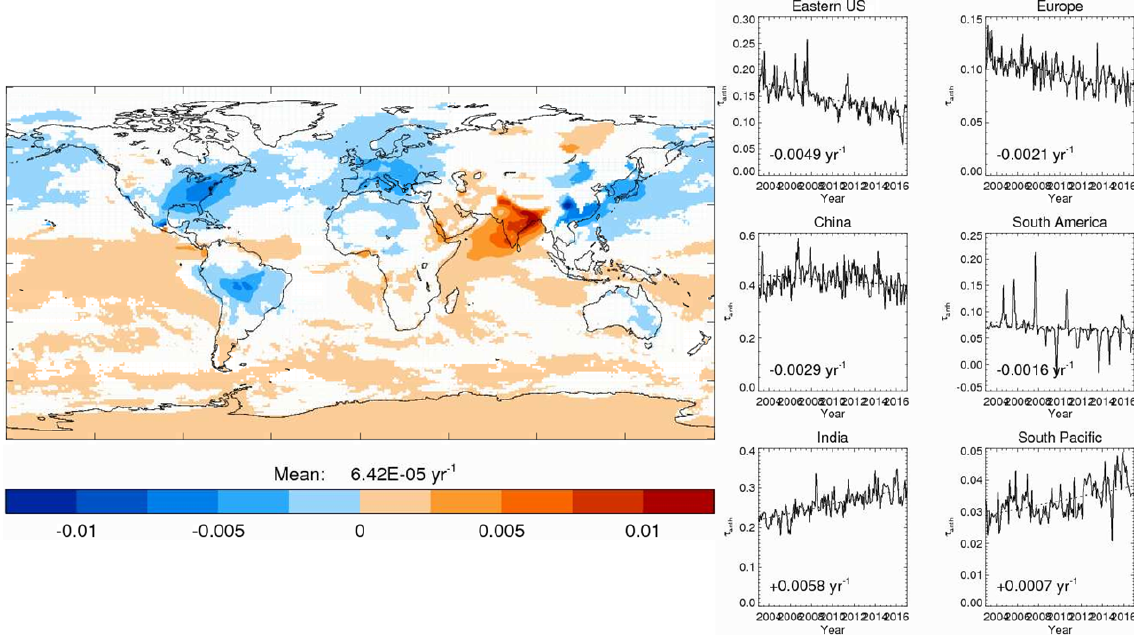
Figure 15. Linear trends (yr − 1 ) in anthropogenic aerosol optical depth at 0.55µm over the period 2003–2017 according to the CAMS Climate Forcing aerosol origin identification algorithm. Regions where trends are statistically insignificant are masked in white. Right-hand- side plots show time series of anthropogenic aerosol optical depth ( τ anth ; solid lines) and their linear fits (dashed lines) in selected